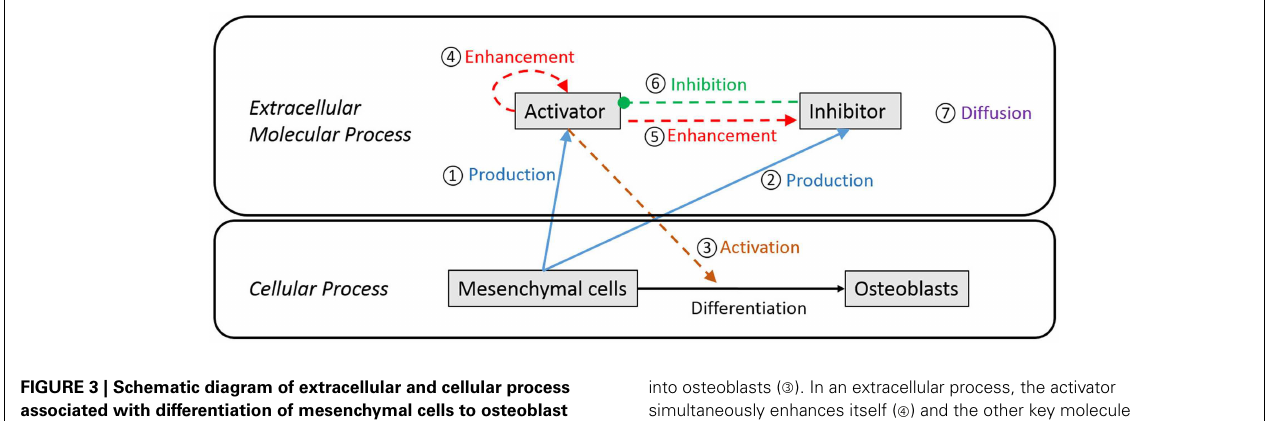
FIGURE 3 | Schematic diagram of extracellular and cellular process associated with differentiation of mesenchymal cells to osteoblast cells . Undifferentiated mesenchymal cells surrounding the brain express diffusible extracellular molecules, which play a key role in cell differentiation ( (cid:129) and ‚ ). One of the molecules (activator) activates signaling pathways to initiate cell differentiation of mesenchymal cells